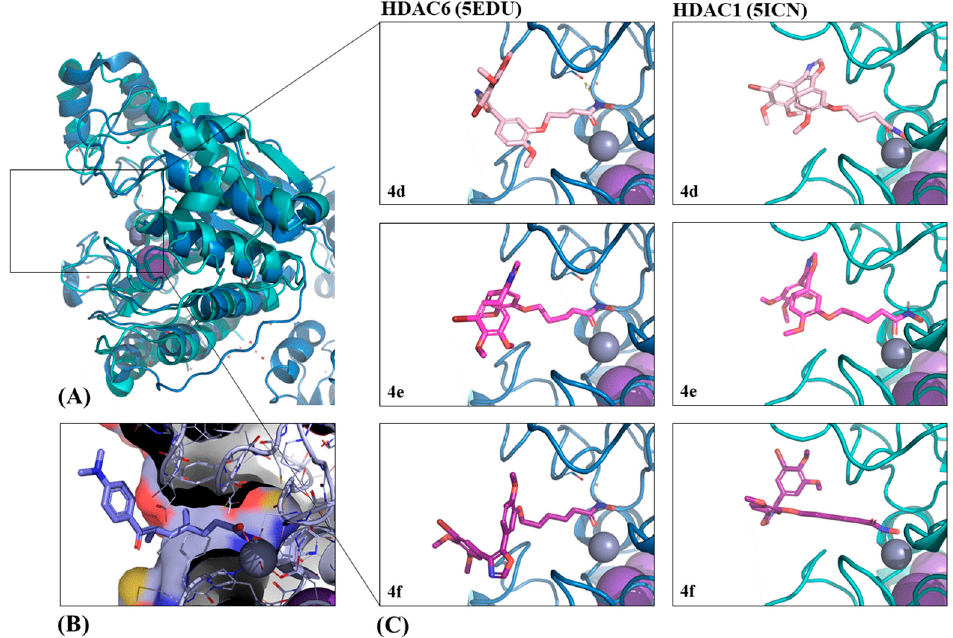
Figure 9. ( A ) Aligned PDB structures of HDAC1 (PDB code: 5ICN) and HDAC6 (PDB code: 5EDU). ( B ) Surface visualization of HDAC6 binding site with co-crystallized ligand trichostatin A (PDB code: 5EDU). ( C ) Selected binding pose predictions exported from SeeSAR and visualized with PyMOL.